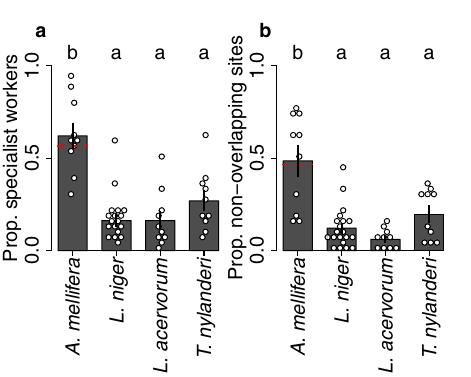
Fig. 3 | Honeybee colonies exhibit greater socio-spatial segregation than ant colonies. Points represent colony means. Bars & whiskers indicate grand means and standard errors. a Proportion of specialist workers (individuals that belong to only one module). The red line shows the case when the two A. mellifera nurse modules were treated separately, rather than being pooled. General linear model (GLM); proportion of specialist workers~species, F 3,46 =15.7, p <0.0001. Letters above bars indicate Benjamini-Hochberg (BH) corrected post-hoc contrasts betweenallspeciespairs.Threeantversushoneybeecontrasts: ∣ z ∣ >3.8, p <0.001in each case. b Proportion of non-overlapping sites (sites that belong to only one module). GLM; proportion of non-overlapping sites~species, F 3,46 =16.8, p <0.0001. Three ant versus honeybee contrasts: ∣ z ∣ >4.3, p <0.0005 in each case. All analyses based on n =50 biologically independent colonies. Source data are provided as a source data fi le.